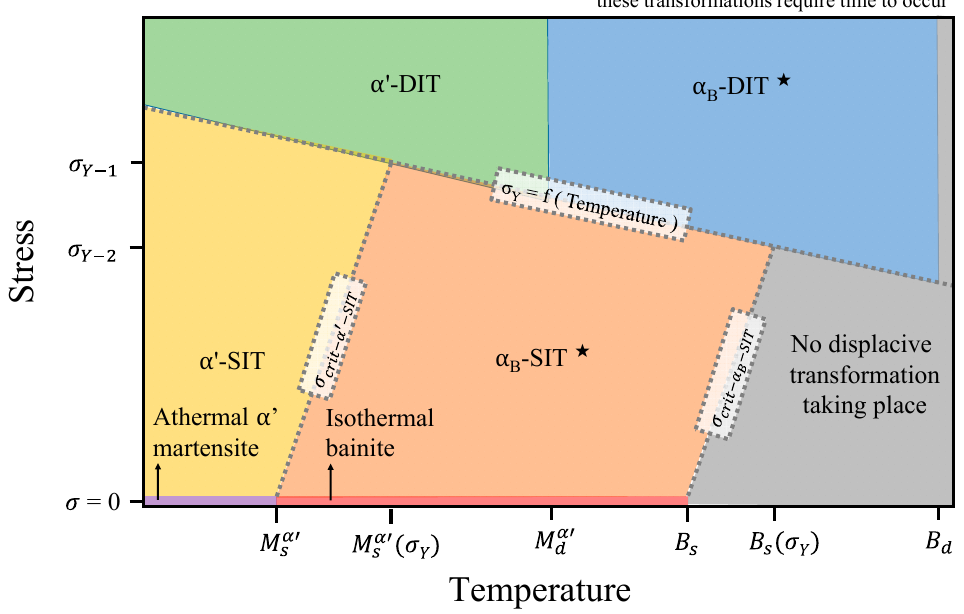
Figure 2. Schematic representation showing the stress–temperature conditions that must be met so that different types of transformations are thermodynamically possible. SIT and DIT stand for stress and strain induced transformation, respectively. Adapted from [64]. Units are arbitrary.